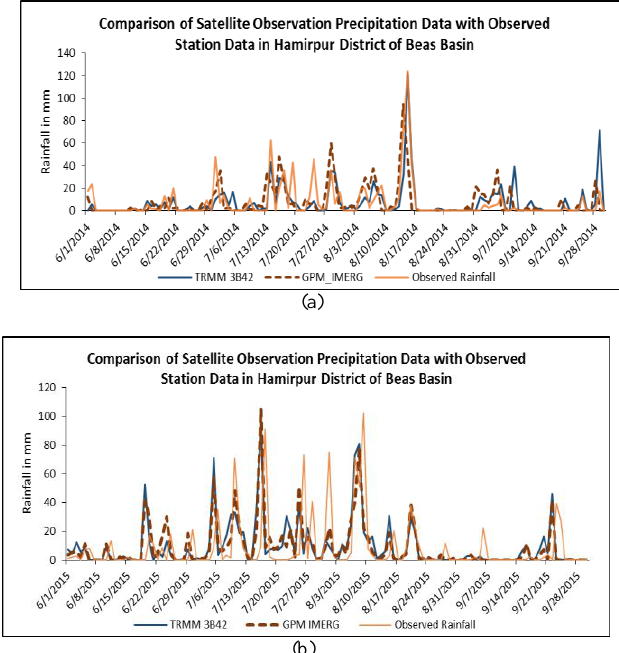
Figure 4: Comparison of TRMM 3B42 and GPM